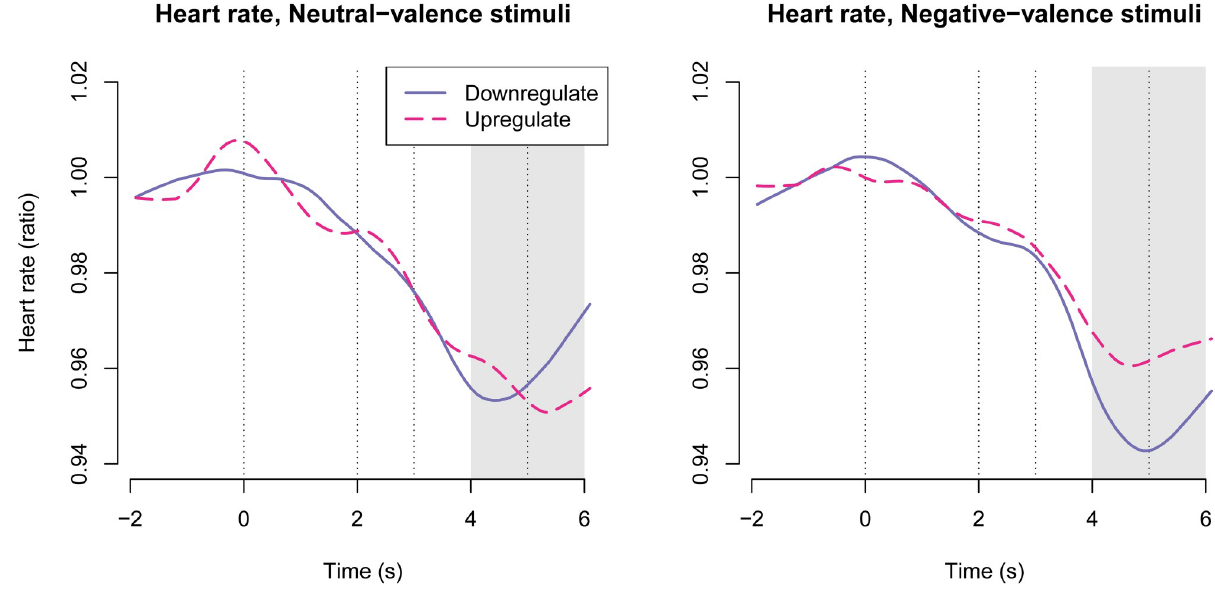
Fig 7. Heart rate time-courses across treatment groups. The first vertical line shows onset of the instruction; the second vertical line shows stimulus image onset; and the third vertical line shows stimulus image offset. The shaded gray area shows the time window from which responses were averaged for statistical modelling.